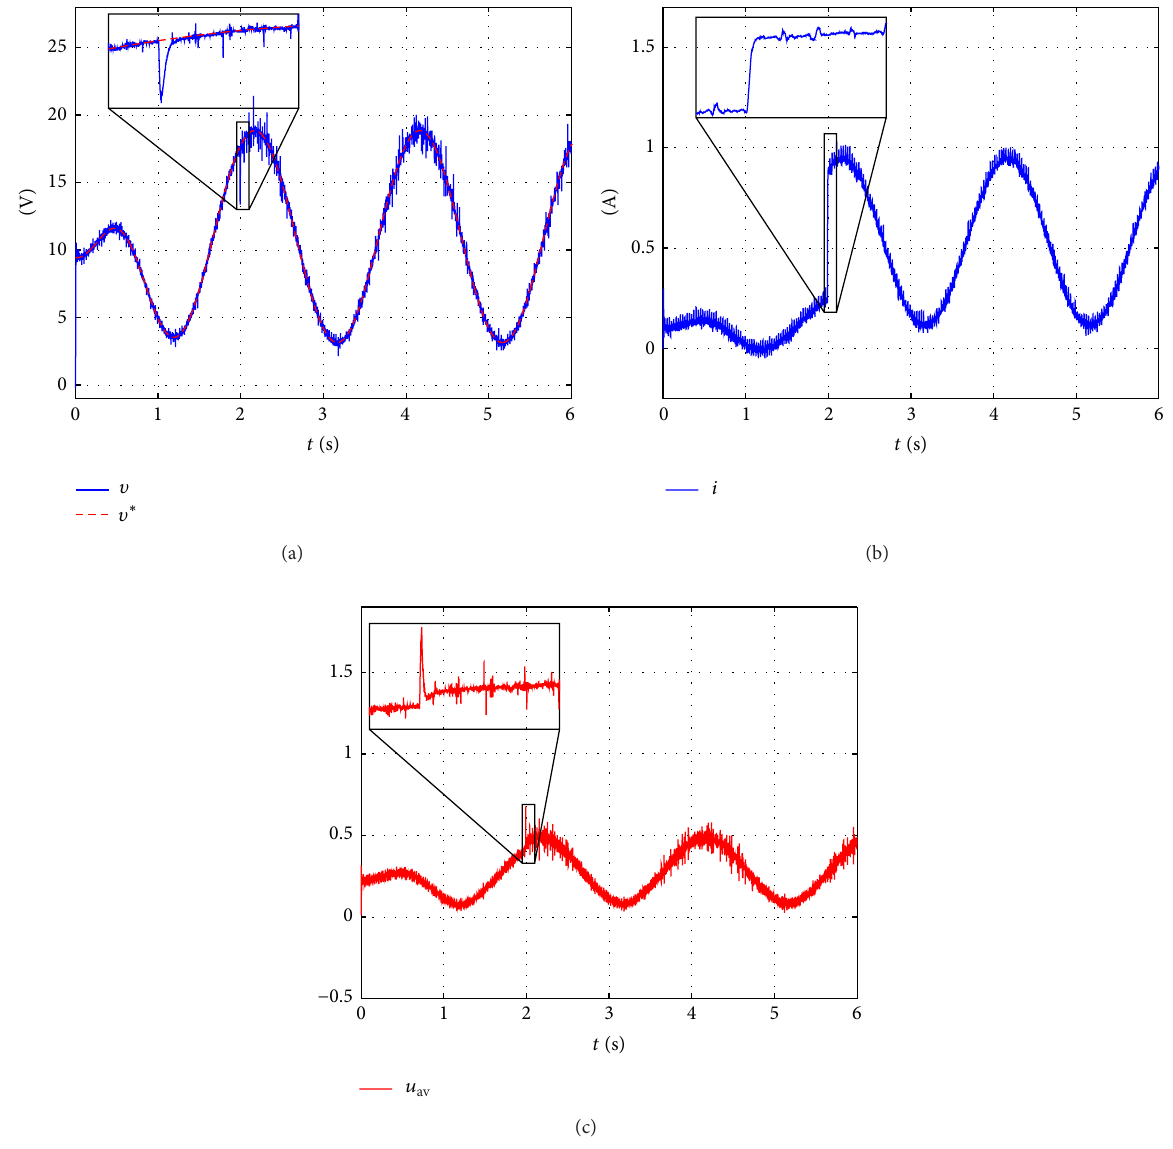
Figure 7: Case (ii) via